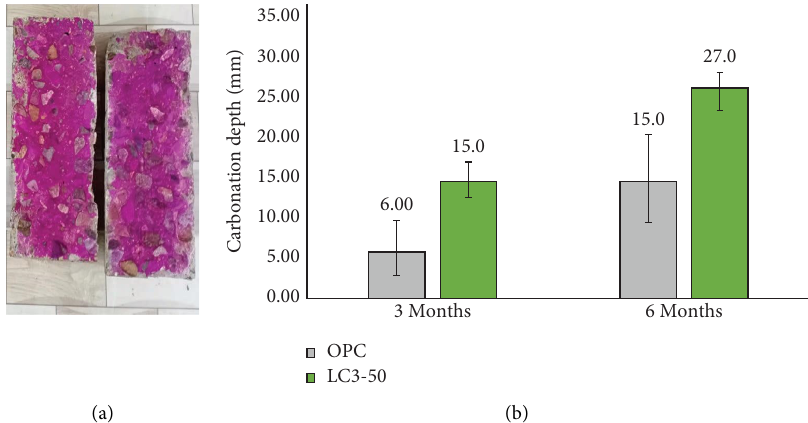
Figure 8: Results of the carbonation test. (a) Sample after exposure and spraying phenolphthalein. (b) Results of the carbonation test with 3 and 6months of